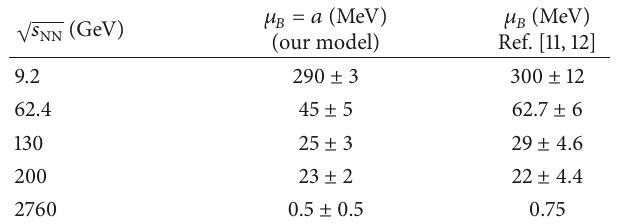
Table 1: The values of chemical potential obtained at different col- lision energies in our model are compared to the values obtained in references [11, 12].